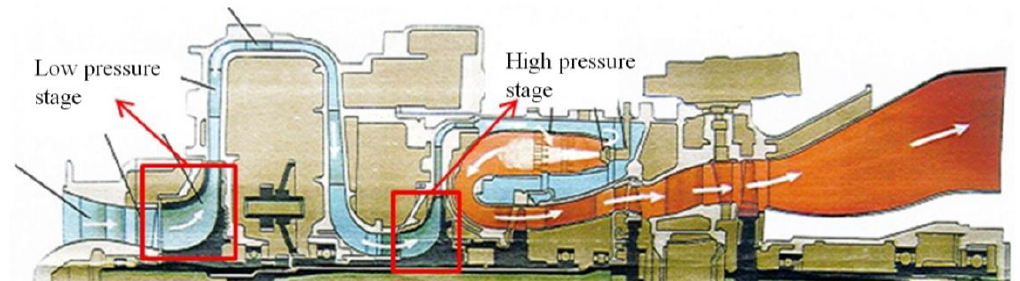
Figure 3. Structure of an MW-level gas turbine.